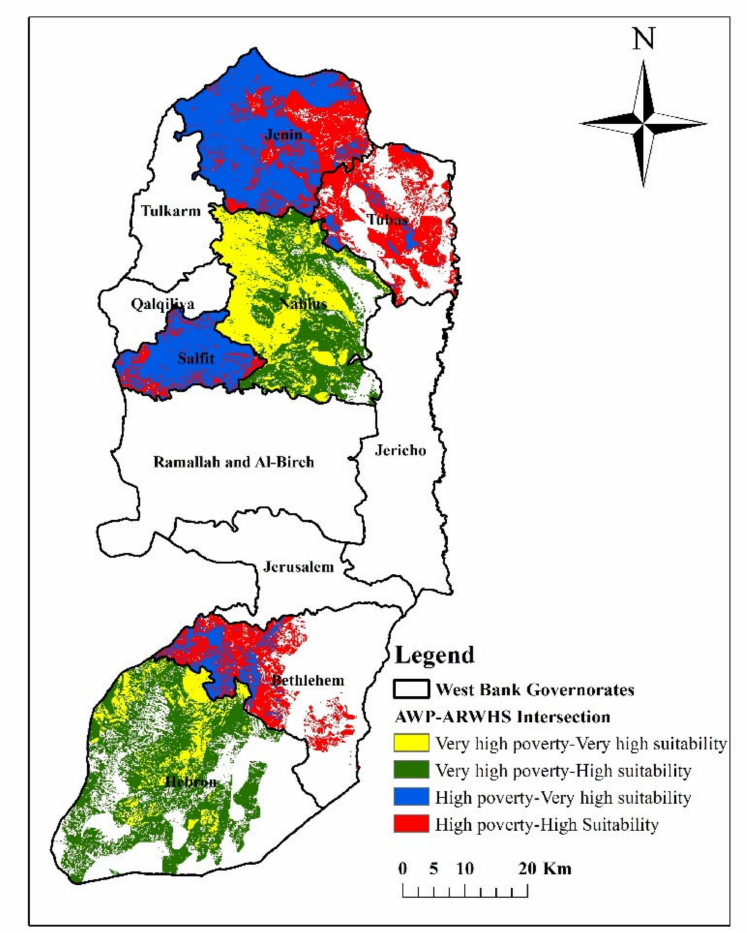
Figure 8. AWP-ARWH intersection map for the West Bank case study.